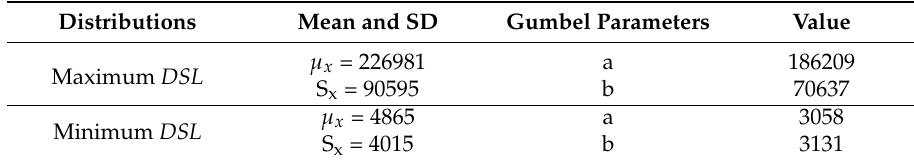
Figure 13. Annual flow volume above the Low and Action flow stages (discharge ≥ 18,000 cms) versus annual sand load at Tabert Landing of the LmMR during 1973–2013. 3.5. Maximum and Minimum Sand Loads for Different Return Periods Averages of maximum and minimum DSL s for each year throughout the whole study period at Tarbert Landing were 226,981 and 4865 tonnes/day, while their standard deviations were 90,595 and 4015 tonnes/day respectively (Table 6). Based on these means and standard deviations, parameters a and b in Gumbel distribution were found to be 186,209 and 70,637 for highest DSL s and 3058 and 3131 for lowest DSL s during each year respectively (Table 6). Table 6. Mean ( µ x ), Standard Deviations (SD) ( S x ) and respective parameters ( a and b ) in Gumbel distribution for maximum and minimum DSL (tonnes/day) at Tarbert Landing of the LmMR from 1973 to 2013.